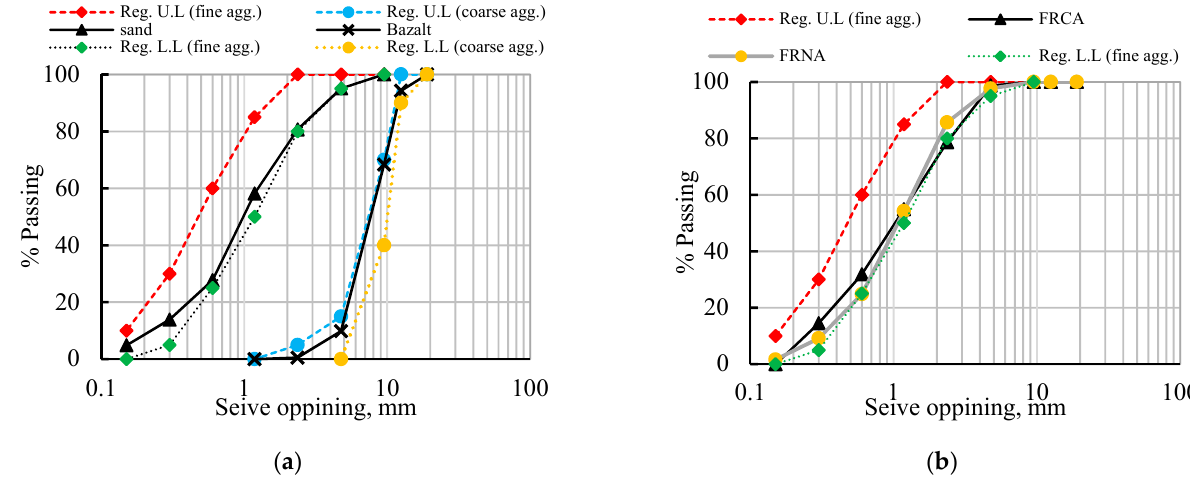
Figure 1. Sieve analysis for natural and recycled aggregates: ( a ) NA; ( b ) RFCA and RFNA. Table 1. The physical properties of natural and recycled aggregate.